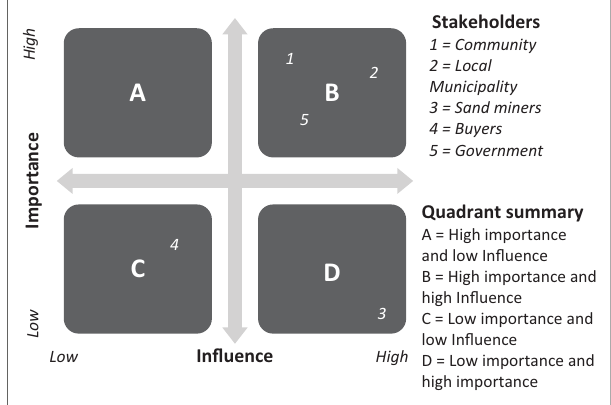
FIGURE 9: Influence and importance